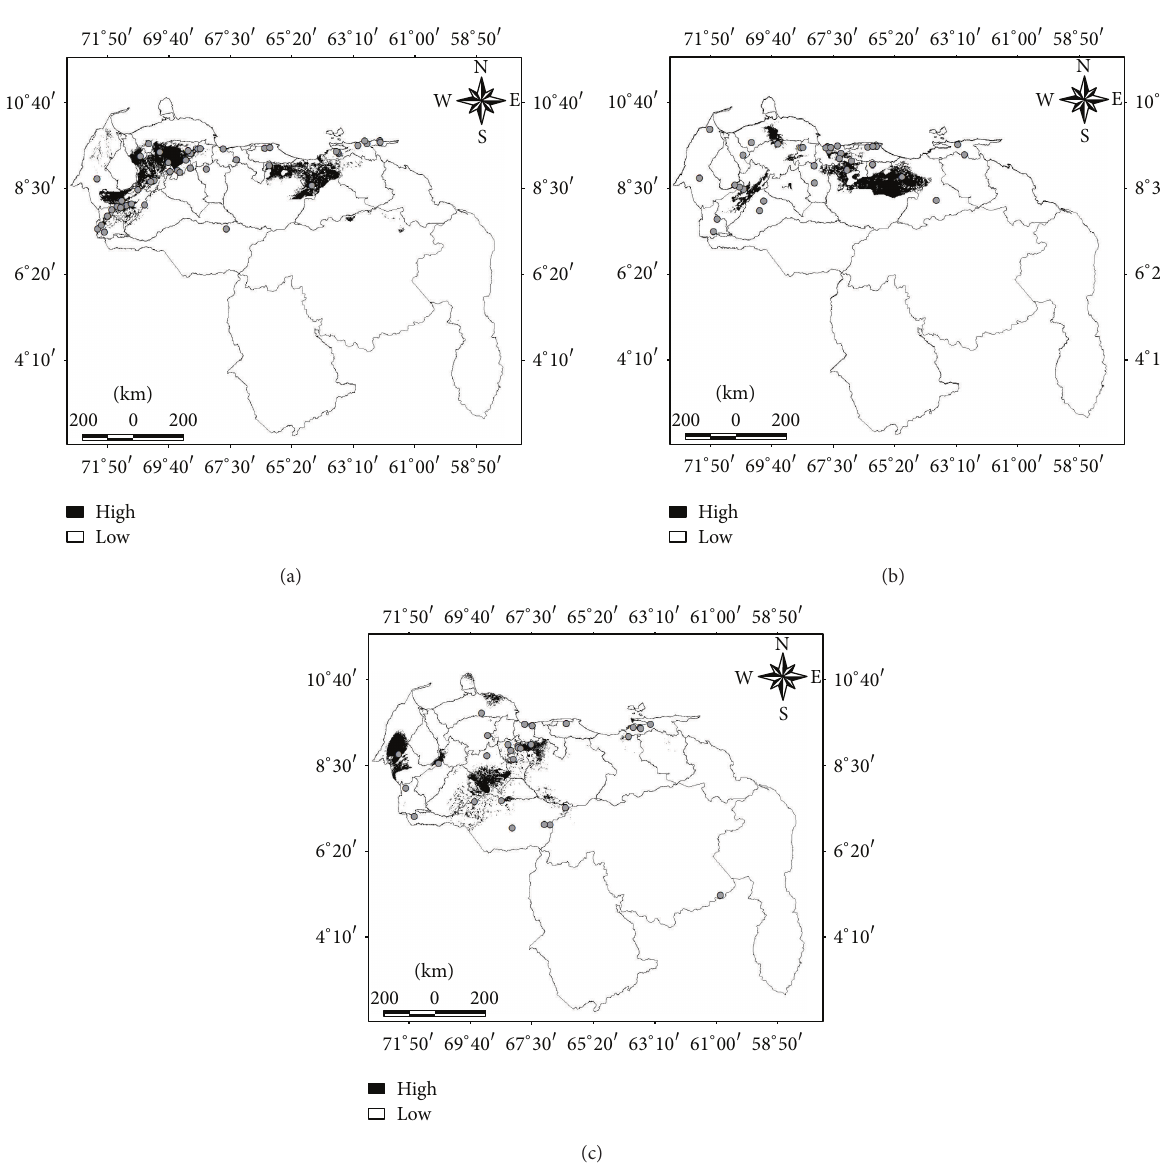
Figure 3: Distribution of sandflies species in Venezuela and gray points denoted occurrences and black areas high probability of relative habitat suitability. Maps are provided for (a) L. ovallesi , (b) L. panamensis, and (c) L. punctigeniculata